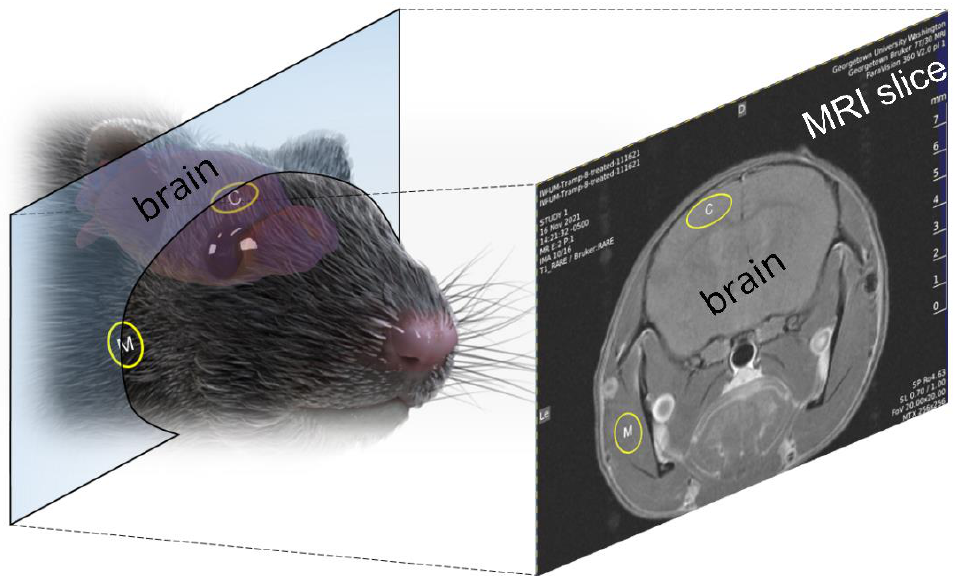
Figure 5. Mouse brain MRI for assessing Gadovist uptake. MRI slices collected of the mouse head were analyzed at two distinct locations, shown above (yellow circles). Gadovist uptake, as characterized by a change in signal intensity before and after EPM pulses, was measured in regions of the cortex (yellow circle with ( C )) and regions of muscle (yellow circle with ( M )) for comparison.